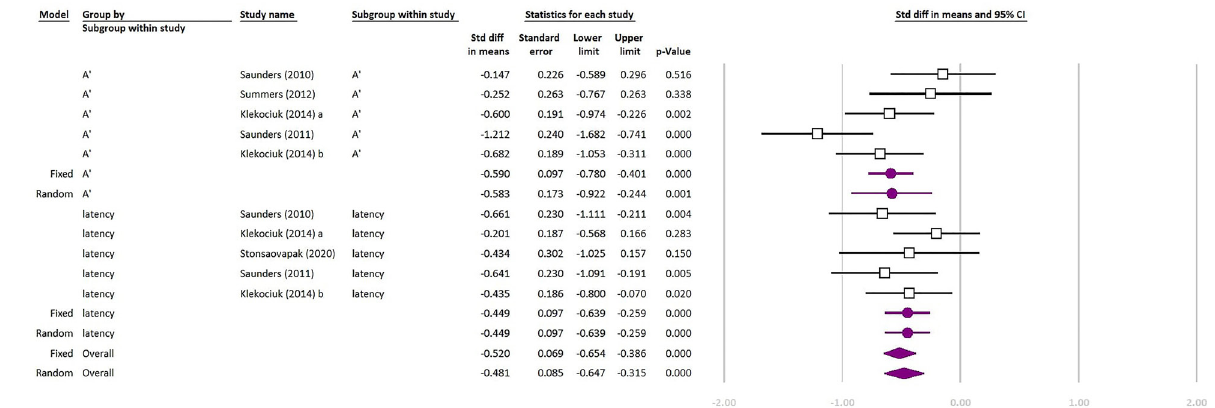
Figure 4. Meta-analysis of comparing patients with mild cognitive impairment and healthy controls based on “A’ and mean latency” measures of Rapid Visual Processing (RVP) test of Cambridge Neuropsychological Test Automated Battery. The purple indicators are the final results. (Test for heterogeneity: overall I 2 : 46.49%; p-value=0.05; A’ I 2 : 67.87 %; p=0.01; Latency I 2 : 0%;